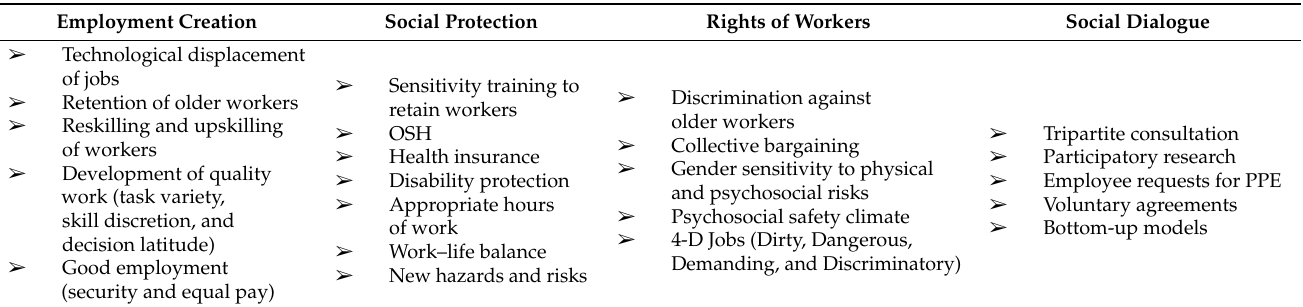
Table 1. Occupational safety and health-related components of the pillars of decent